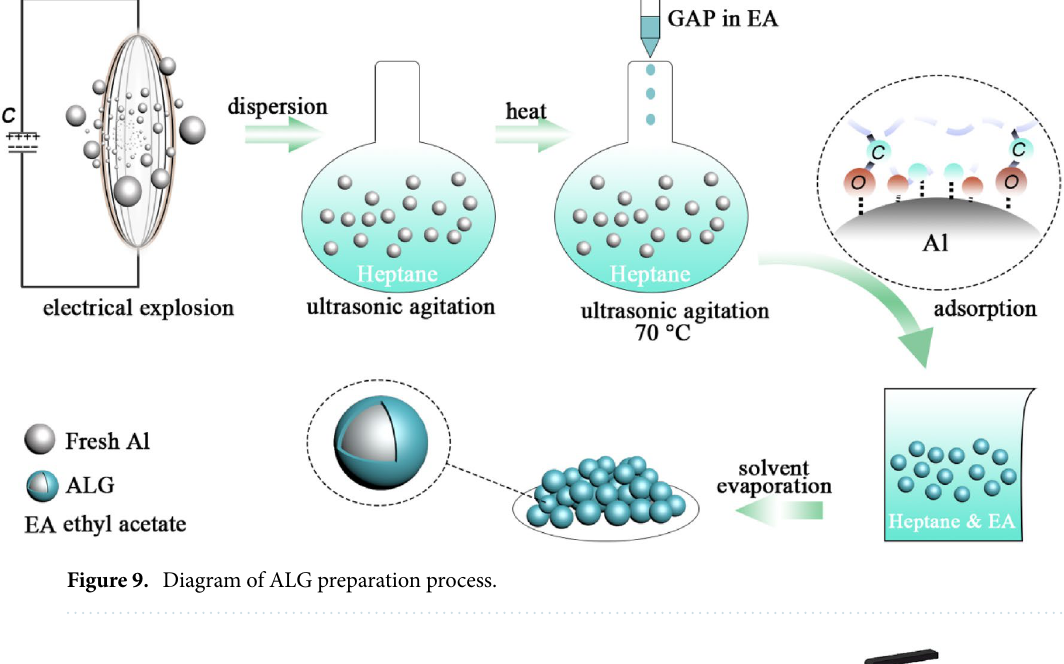
Figure 9. Diagram of ALG preparation process.